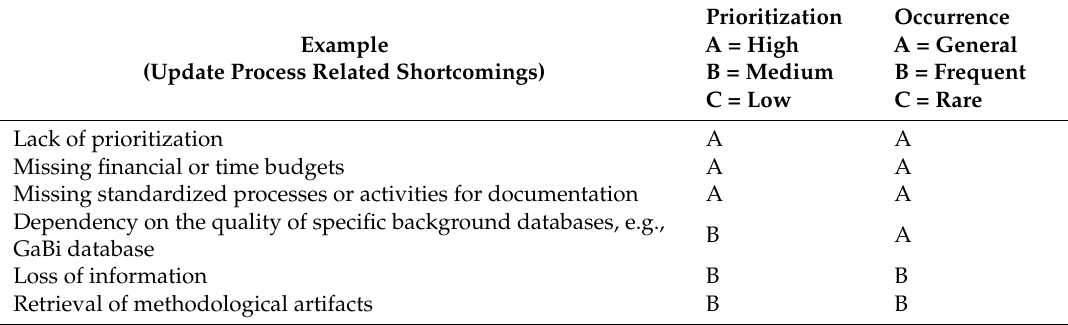
Table 5. Update process related shortcomings–Examples and their prioritization for solution-oriented handling.